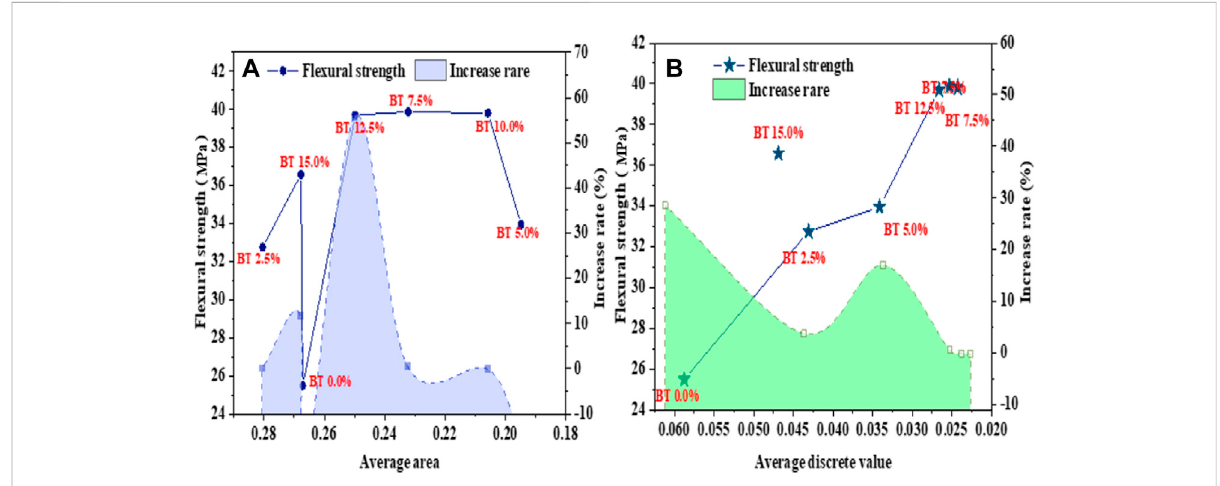
FIGURE 12 Change of fl exural strength with orientation and distribution of steel fi ber: (A) is orientation S , (B) is distribution D .